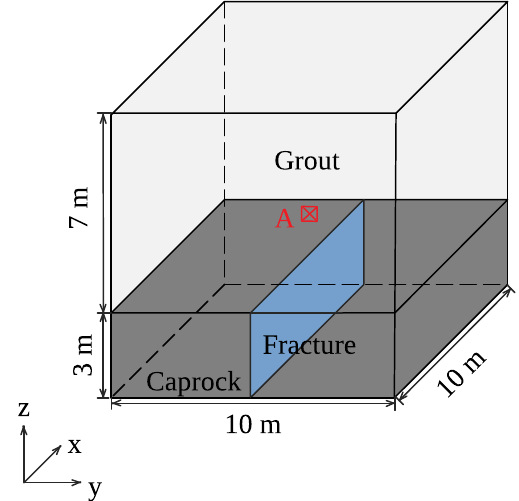
Figure 2. Diagram of reactive grouting for the CO 2 leakage remediation. Reference from [73].